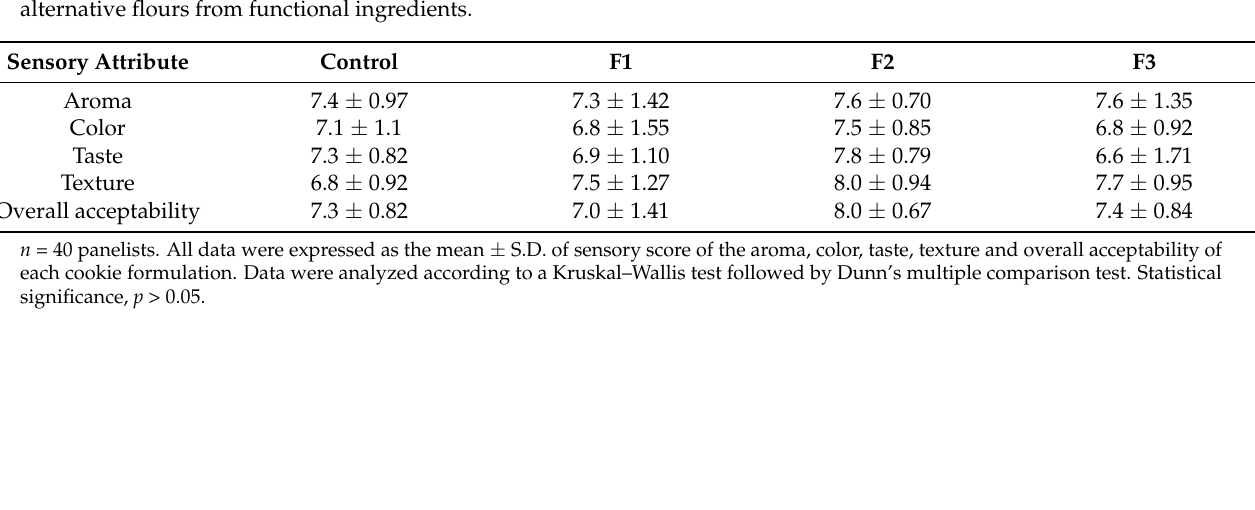
Table 5. Sensory quality evaluation of traditional WWF cookies and those produced with different formulations of alternative flours from functional ingredients.